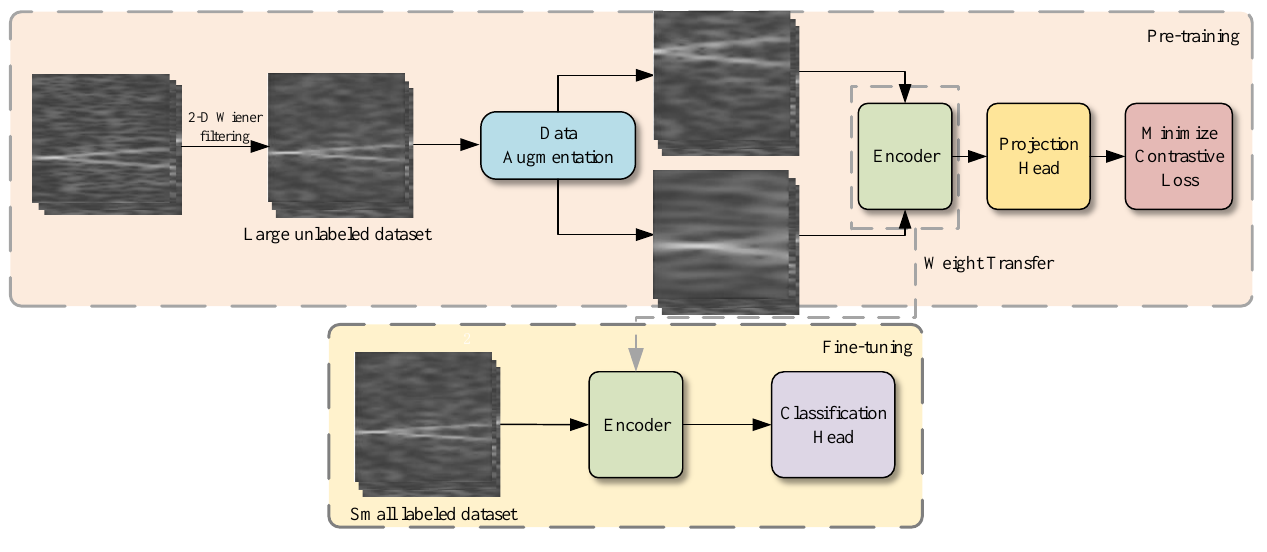
Figure 1. Architecture of the CL – CNN model.